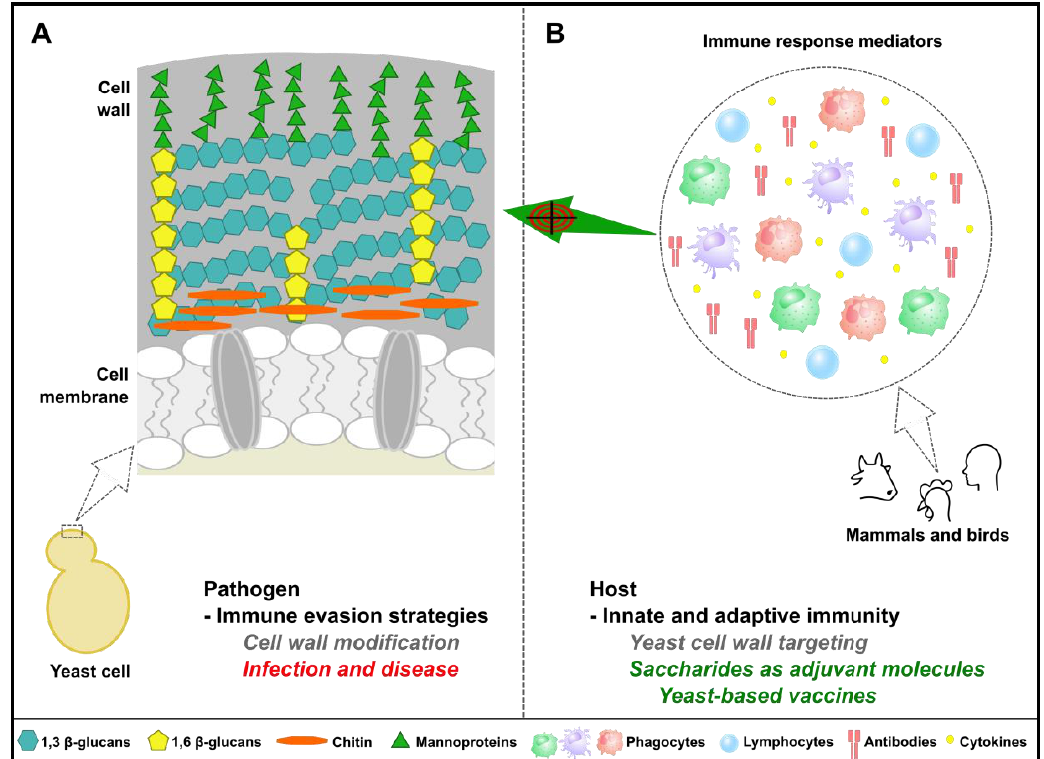
Figure 4. Importance of yeast cell wall components in immune detection and vaccine development. ( A ) Yeast has evolved a sophisticated cell wall enabling better adaptation to harsh environmental conditions. Pathogenic fungi can further modify cell wall components to resist host immune response pressure and cause disease. ( B ) On the other hand, carbohydrates abundantly found in yeast cell wall are absent in mammals and poultry birds, enabling e ffi cient recognition of yeast cells by the host immune surveillance mechanisms, in particular by the innate immune system. This particularity has been exploited for the development of new adjuvant molecules and yeast-based approaches as alternatives to alum-adjuvanted subunit